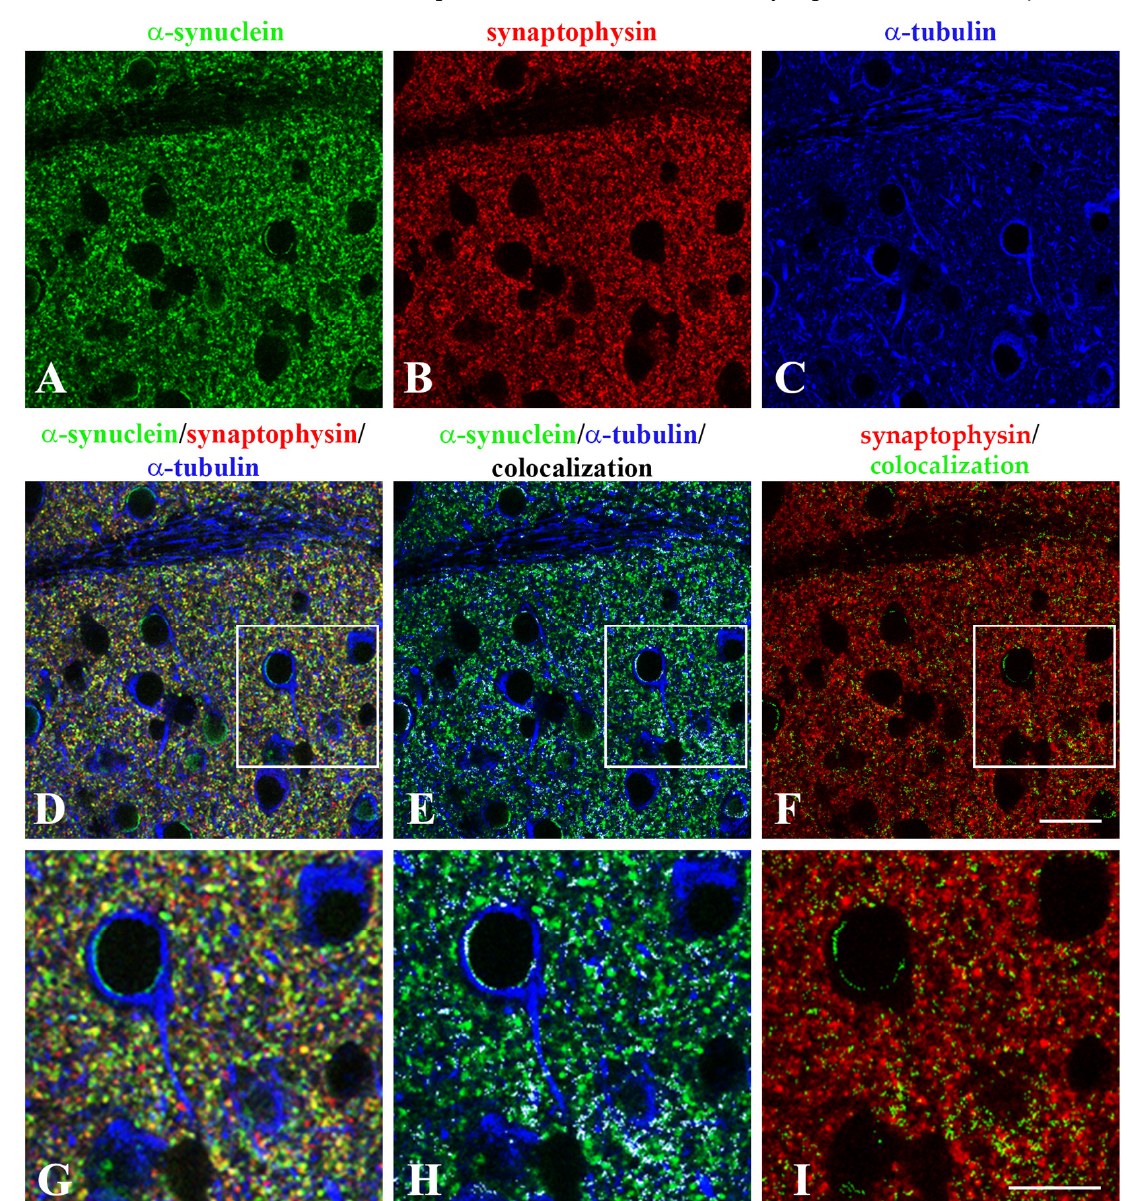
Figure 3. α -synuclein and α -tubulin colocalization in synaptic terminals in the corpus striatum of WT mice. Triple immunofluorescence for ( A ) α -synuclein ( α -syn, green), ( B ) synaptophysin (syp, red), ( C ) α -tubulin ( α -tub, blue) analyzed by confocal microscopy ( n = 4 mice, at least 4 replicates). ( D ): Merge of the triple staining. The region marked by the white square in ( D ) is magnified in ( G ). ( E ): The colocalization between α -synuclein (green) and α -tubulin (blue) is shown as the white mask. The region marked by the white square in ( E ) is magnified in ( H ). ( F ): Merge of synaptophysin (red) with the α -synuclein/ α -tubulin colocalization mask (green). The region marked by the white square in ( F ) is magnified in ( I ). Scale bars: 25 µ m ( A – F ), 40 µ m ( G – I ).